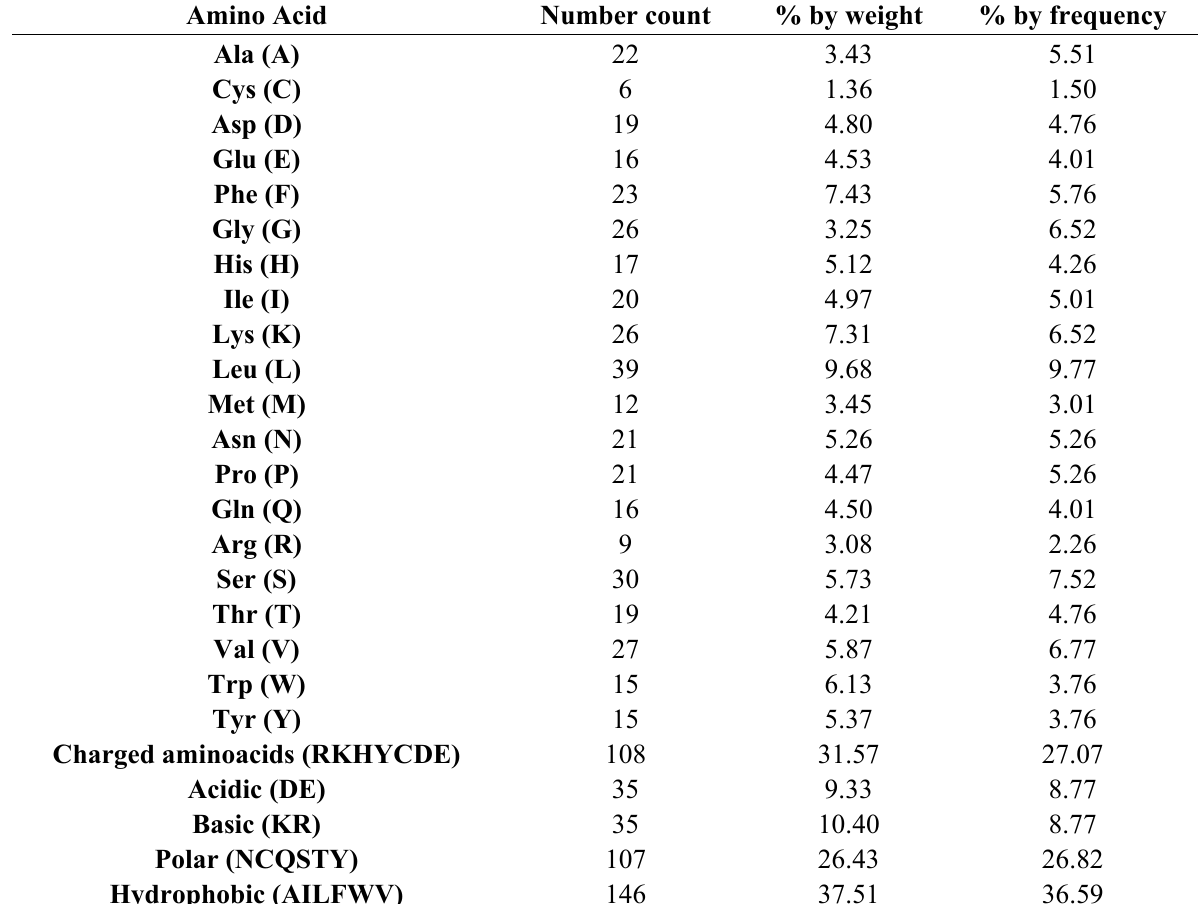
Table 1. Predicted chemical composition of the cloned full length of cLIPA using protean program [17].